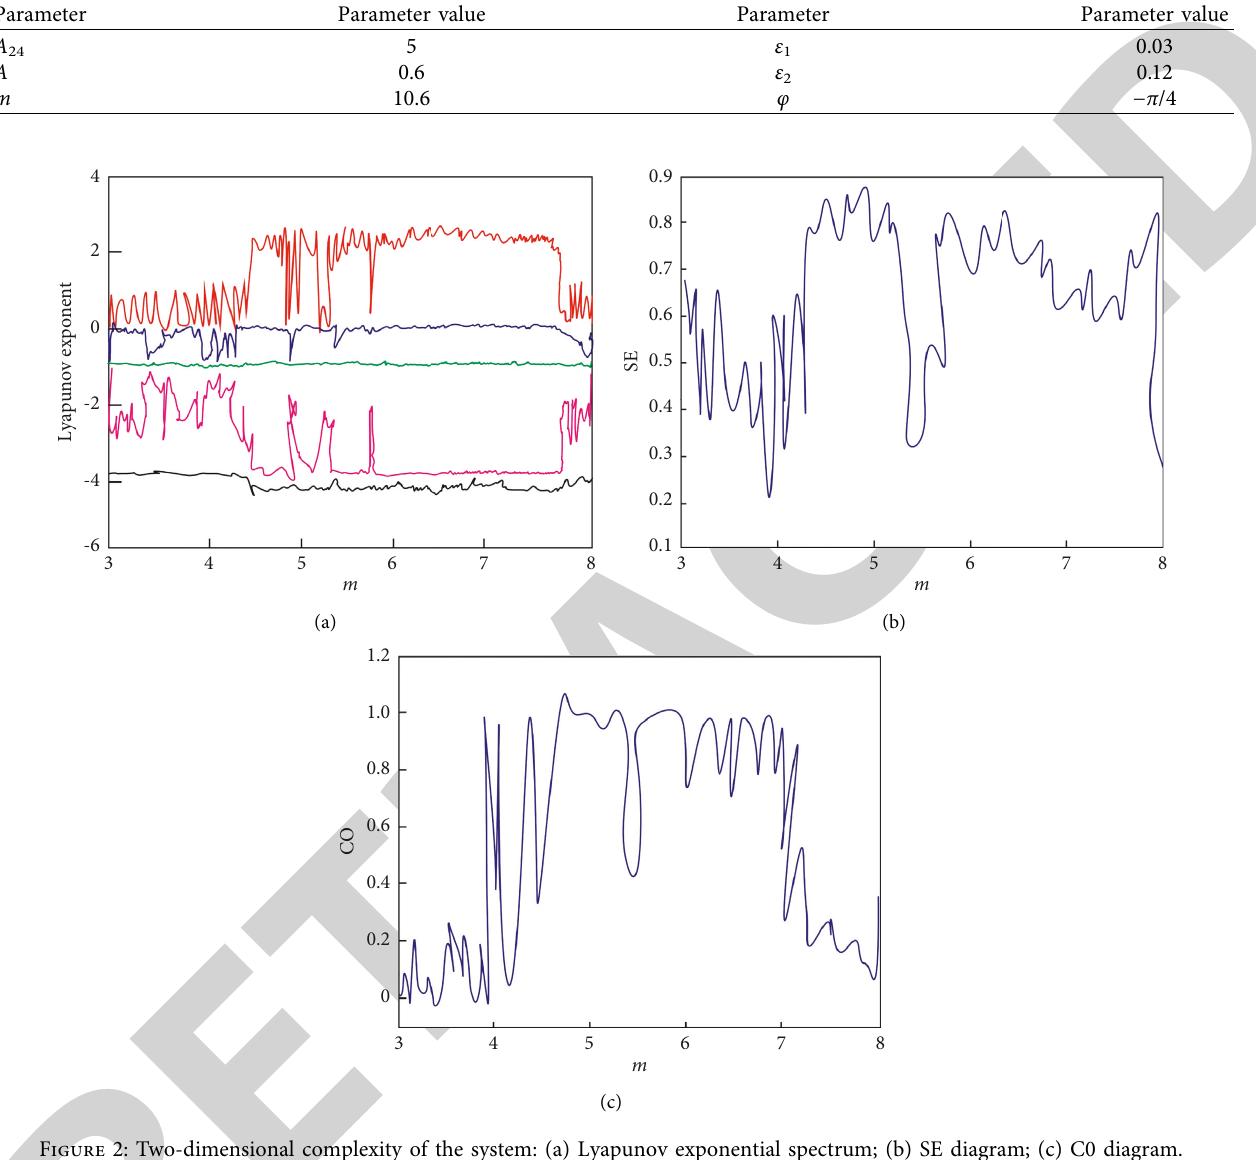
Figure 2: Two-dimensional complexity of the system: (a) Lyapunov exponential spectrum; (b) SE diagram; (c) C0 diagram. 3.0